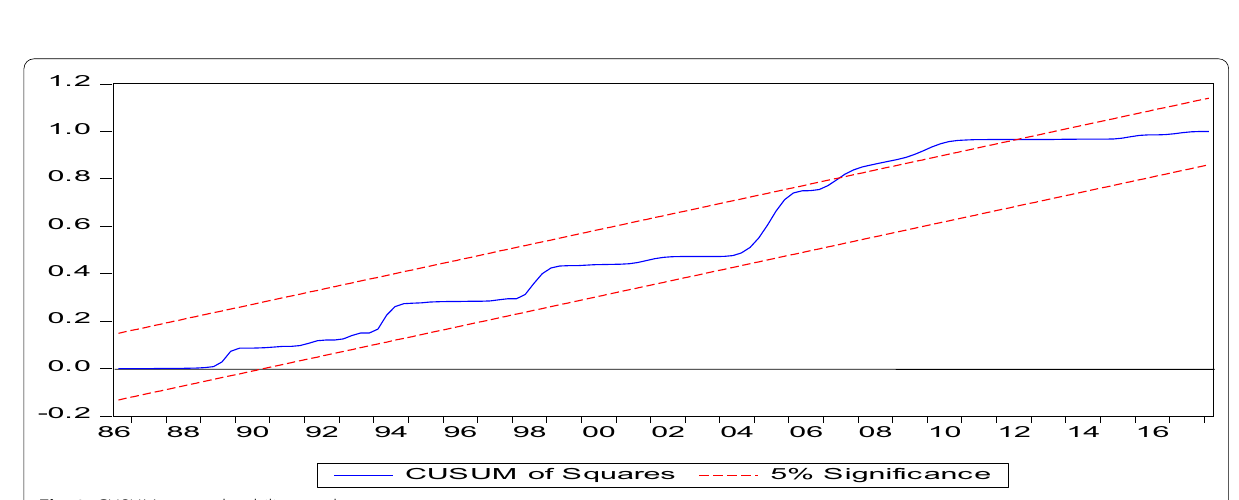
Fig. 2 CUSUM squared stability